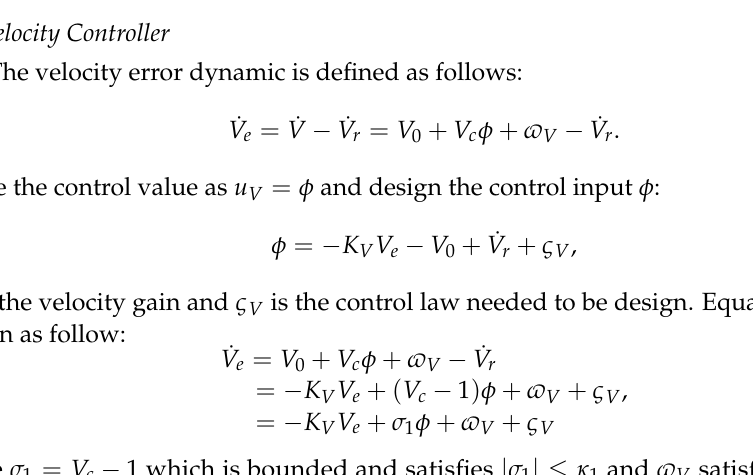
Figure 2. Fault tolerance of hypersonic aircraft by L 1 adaptive